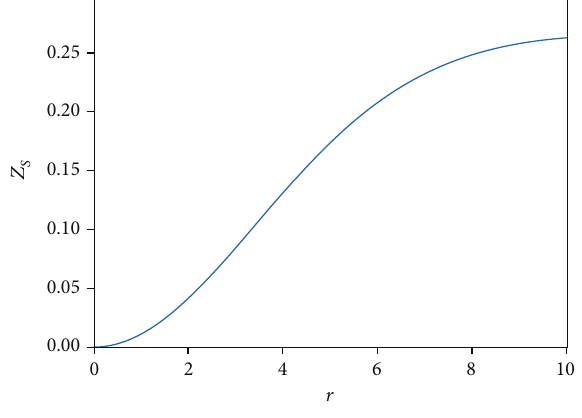
Figure 3: Radial pressure ð p radial distance r .